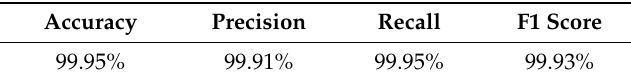
Table 7. Proposed system results.